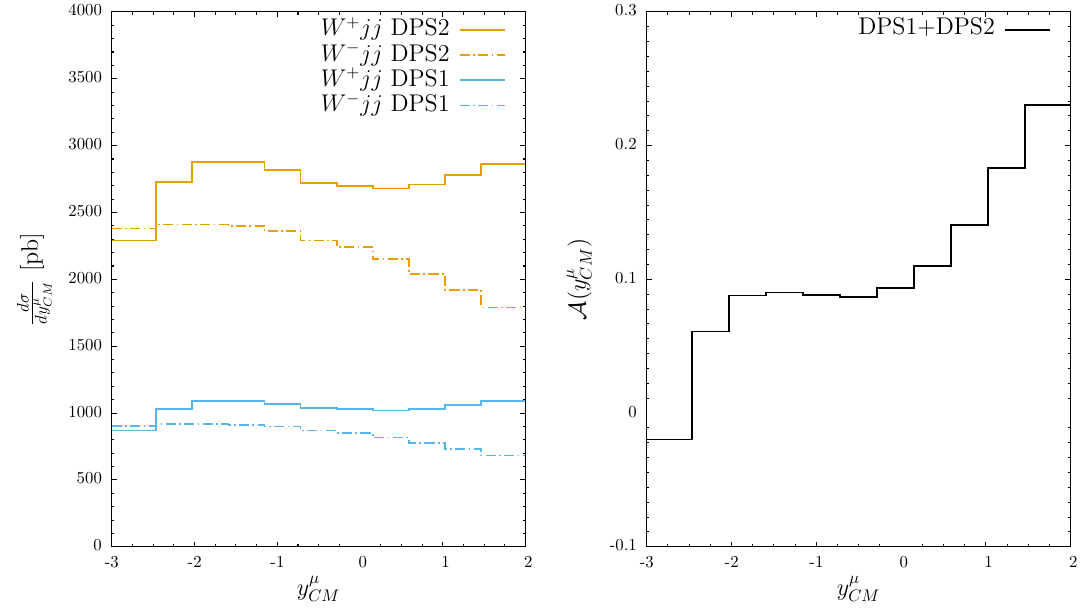
Fig. 4 W jj DPS cross sections in pA collisions as a function of the charged muon rapidity in the proton-nucleon centre-of-mass frame (left) and the corresponding muon charge asymmetry (right)